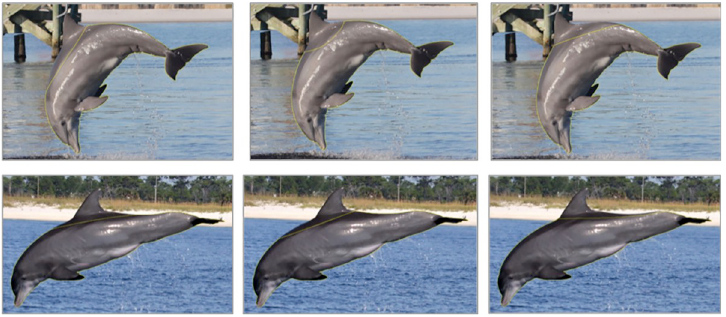
Fig 3. Traces of dolphin bodies used to determine what 10% of the dorsal surface would look like at different surfacing angles. Traces completed in Image J by calculating the number of pixels traced of the entire dolphin and then excluding 10% of those pixels from the dorsal